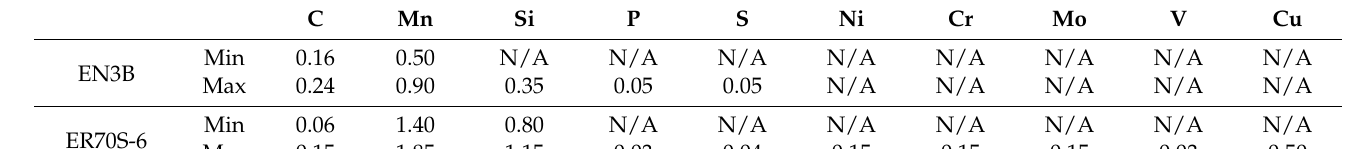
Table 1. Chemical composition of filler wire and substrate material.